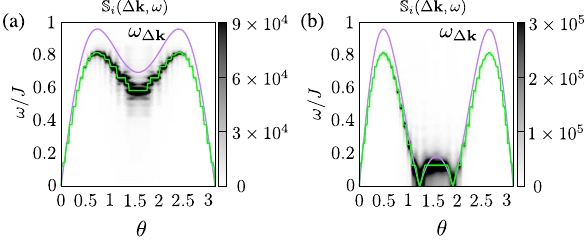
FIG. 24. RPA scattered spectrum at zero temperature along ϕ ¼ π = 4 for U ¼ 8 . 3 J ( m ≃ 0 . 30 ). This figure only shows the RPA low-energy part of the spectrum that includes the collective modes. Single-particle excitations occur at much higher energies and are not shown. The gray scale on the left gives the magnitude of the spectrum plotted. Panel (a) shows the case κ ¼ 1 . 05 , and (b) shows the case κ ¼ 1 . 5 . ω Δ k (solid line), given by Eq. (49), is the spin-wave dispersion relation of the Heisenberg model. The green (steplike) line connects the maximum values of the collective mode peak of the RPA spectrum for each θ point